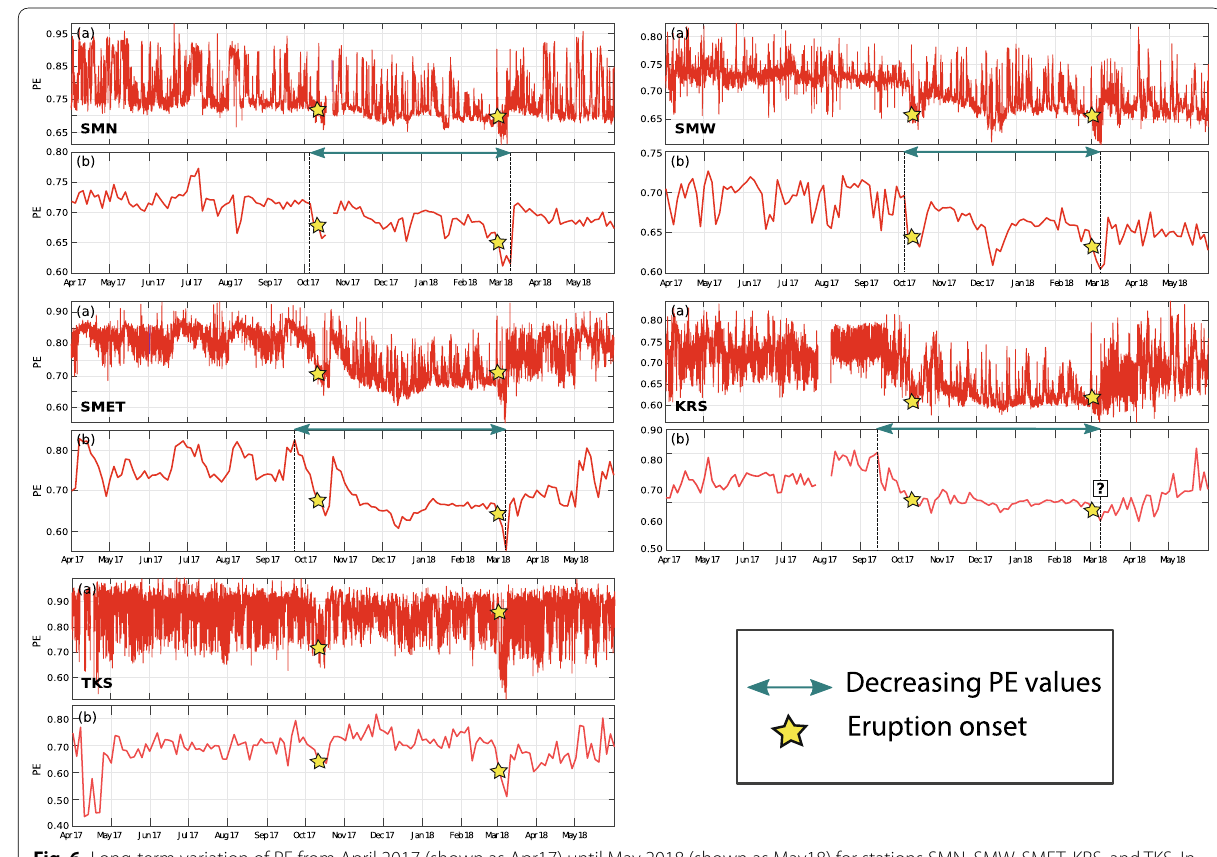
Fig. 6 Long-term variation of PE from April 2017 (shown as Apr17) until May 2018 (shown as May18) for stations SMN, SMW, SMET, KRS, and TKS. In each plot panel a shows the PE variation every 20 min, and panel b corresponds to the PE variation after applying a moving window of 3 days. At station KRS the end of the decreasing period of PE is not clear; hence, this is indicated by a question mark